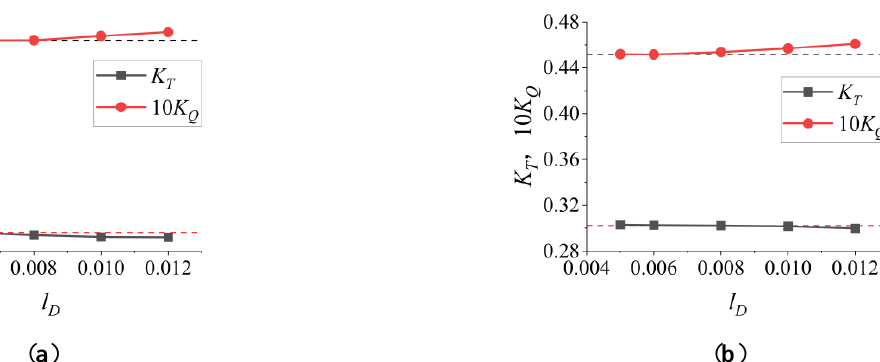
( b ) Figure 4. Calculation domain ( a ) and the mesh encryption ( b ). The mesh on the blade surface was bound to be encrypted, as well as the rotating region and the wake area of the stationary region. A circular tube-type wake encryption zone was set behind the propeller to facilitate the capture of the wake velocity field and vortex distribution of the propeller, as shown in Figure 4b. Due to blade tip rake changes, Kappel propellers have striking differences in terms of their geometric structure, which may affect the mesh independence analysis. Therefore, two representative propellers, Kap01 and Kap04, respectively, with smaller tip rake and larger tip rake, were selected for mesh independence analysis. The mesh independence was explored using Kap01 and Kap04, comparing five cases with the base sizes of 0.005 D , 0.006 D , 0.008 D , 0.01 D , and 0.012 D under the same mesh strategy. Here, the base size of mesh is denoted as l D . Set the rotation speed to 12 rps and the advance speed coefficient J to 0.5. In Figure 5, the simulation results turn stable when the